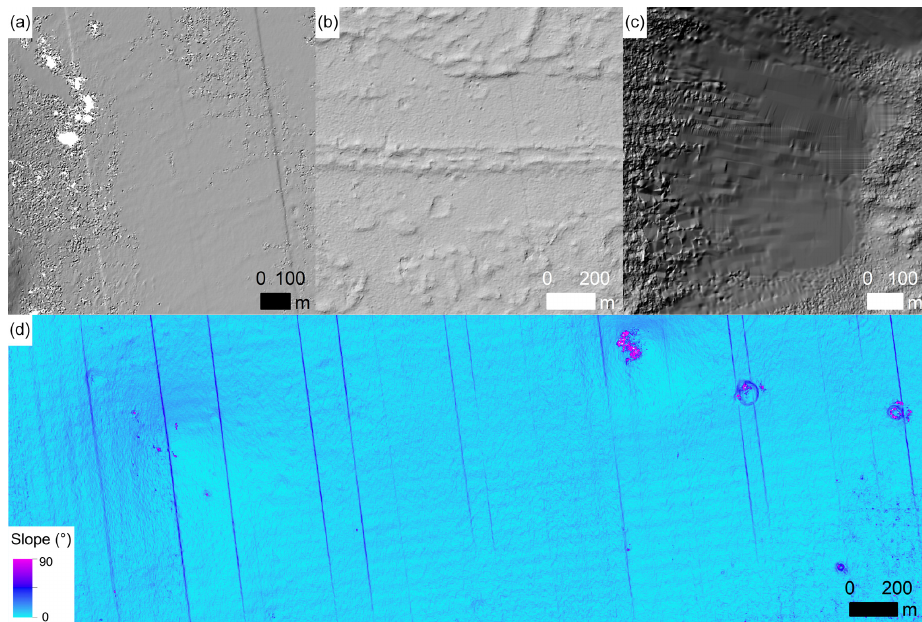
Figure 4. Several visible artefacts present in AU and PDS HiRISE DEMs. (a) Pixel-matching failures associated with low-terrain texture in AU DEM 3. Longitudinal foliations are also visible and are more clearly seen in (d) . These foliations are not clearly visible in either input image, but arise in the DEM because HiRISE images consist of 14 individual bands, 10 of which must be stitched together to create a single image. (b) Further longitudinal foliations associated with individual HiRISE bands, this time present in the PDS DEM for site 1 (DTEEC_002118_1510_003608_1510_A01: https://bit.ly/2tSD8Ig, last access: 1 February 2019). (c) Artificial smoothing present in the site 1 PDS DEM. In lieu of pixel-matching information, the SOCET-SET algorithm has been used to fill in the data gaps, resulting in the smooth artefact. In the ASP workflow presented here, gaps in data due to pixel failure are left as is, leaving the empty pixels visible in (a) . (d) Longitudinal foliations clearly visible in a slope map generated from AU DEM